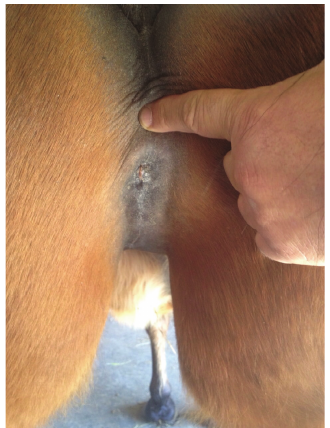
Figure 3: Macroscopic appearance of the perineal urinary meatus 3 years after surgery: urethral stoma underwent a progressive contraction until stabilization, allowing normal urination without urine